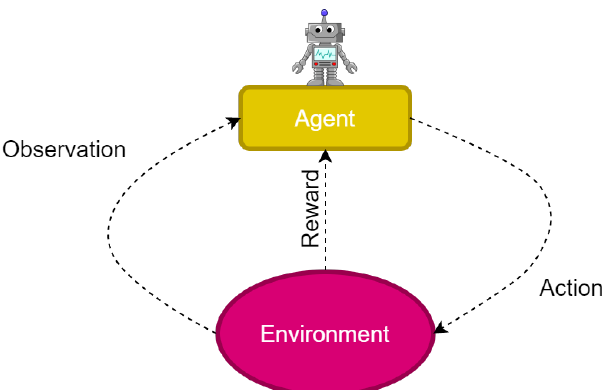
Figure 9. Process flow of machine learning agent in the AR application, following the reinforcement